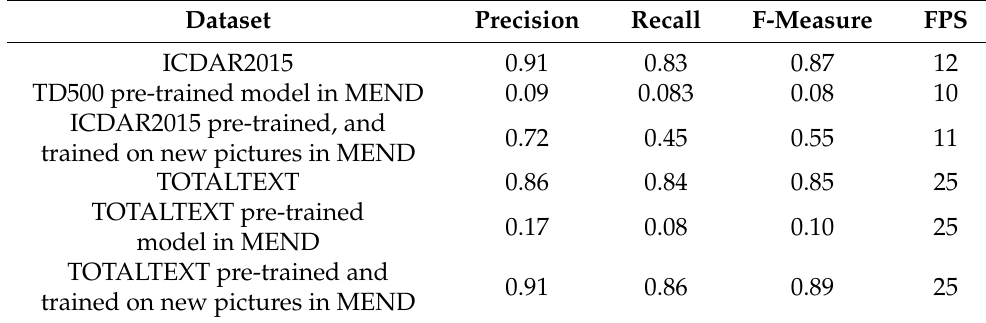
Table 5. Comparative test results of the SAST approach using the ResNet50-D network as a backbone for text recognition in complex industrial scenarios. To optimize its performance, the approach is initially trained on the TOTALTEXT dataset and then fine-tuned on new images. The results show that the SAST approach achieves high accuracy while maintaining appropriate recognition